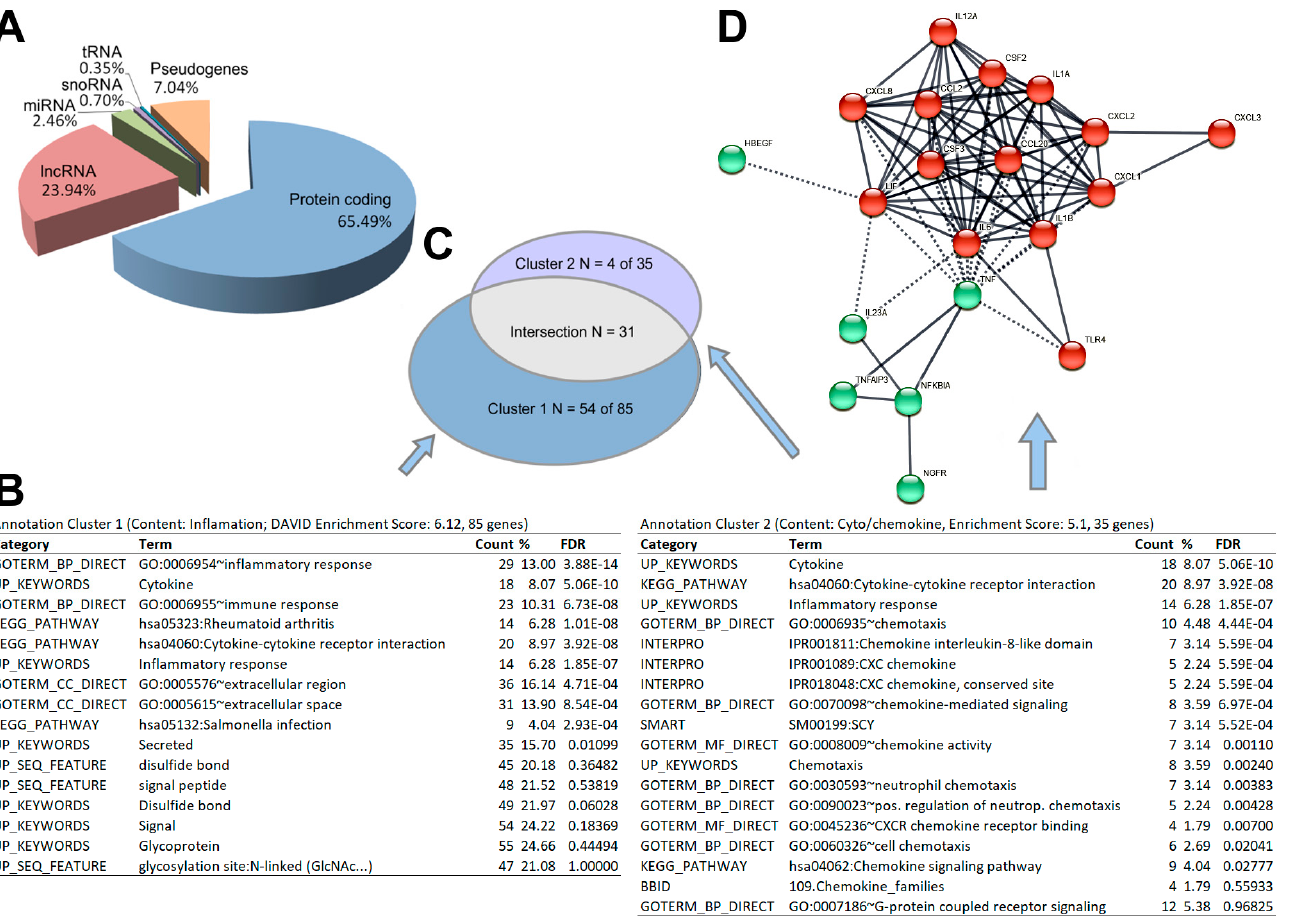
Figure 3. Results of the post hoc analyses on 298 genes. ( A ) Functional assembly of differentially expressed genes. ( B ) Result of the annotation clustering. The two most stringent clusters with an enrichment score > 5 are shown. ( C ) Venn diagram of the two functional enrichment clusters. ( D ) STRING protein–protein interactions of annotation cluster 2 genes.